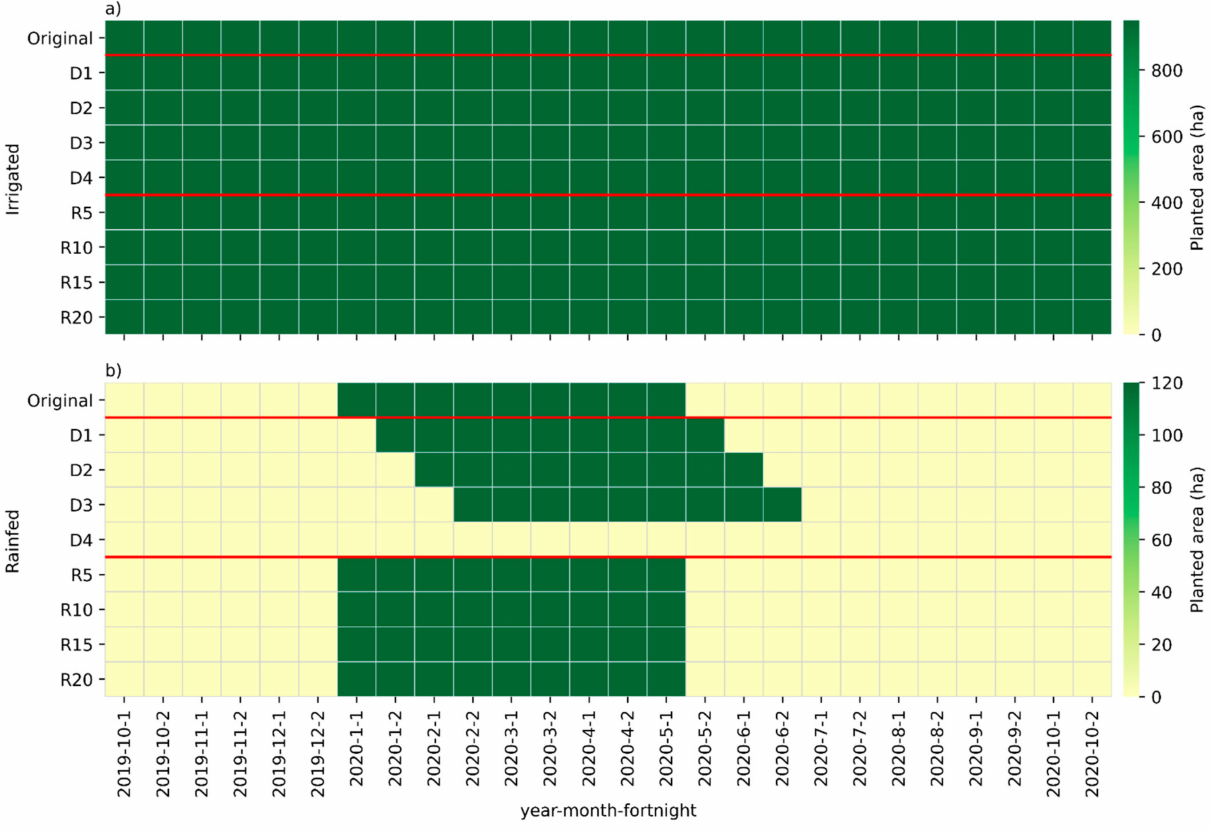
Figure 5. Planted area, in hectares, recommended by LPM application at Floryl farm. ( a ) Shows the results for irrigated areas. ( b ) Shows the results for rainfed